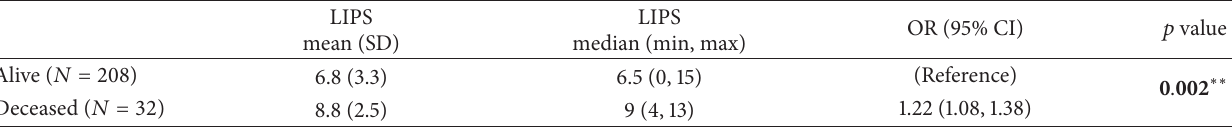
Table 3: Univariate association between LIPS and mortality.